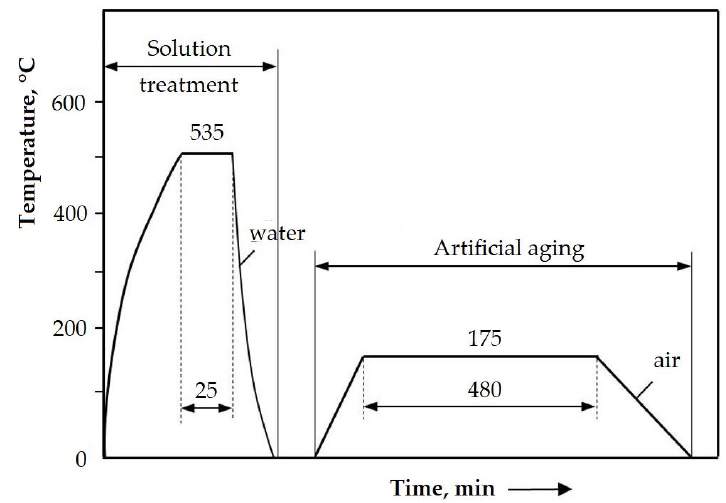
Figure 1. Heat treatment cycle. Figure 2, the microstructure obtained after this heat treatment was composed of γ solid solution grains with an aluminum base having a polyhedral shape, and inside and on the separation boundaries between them, there were particles of intermetallic phases, consisting of Mg 2 Si for the large ones, Al 5 FeSi for those in the form of a plate, and Al 12 (Fe, Mn) 3 Si for the spherical ones [18]. This alloy shows the highest values for the mechanical resistance characteristics among all the 6xxx series alloys and is used in the aeronautical, marine, automotive and food industries [7,18]. ( a ) Intermetallic compounds